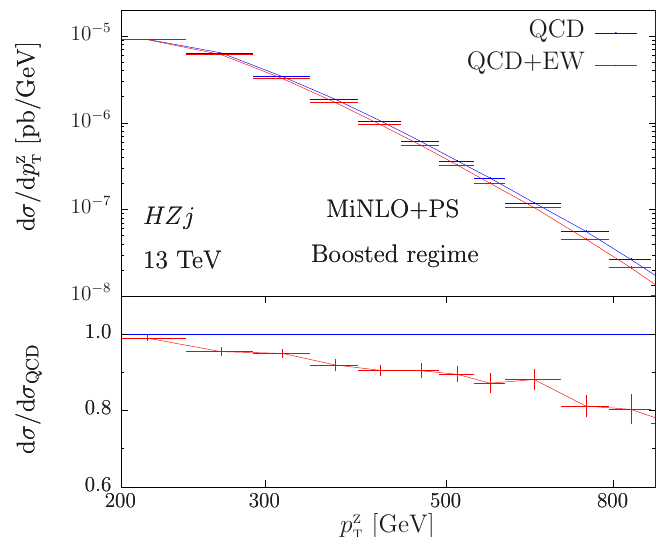
Figure 23. MiNLO +PS predictions for the transverse momentum of the Z boson for HZj production in the boosted regime. Same curves and labels as in (cid:12)gure 20.